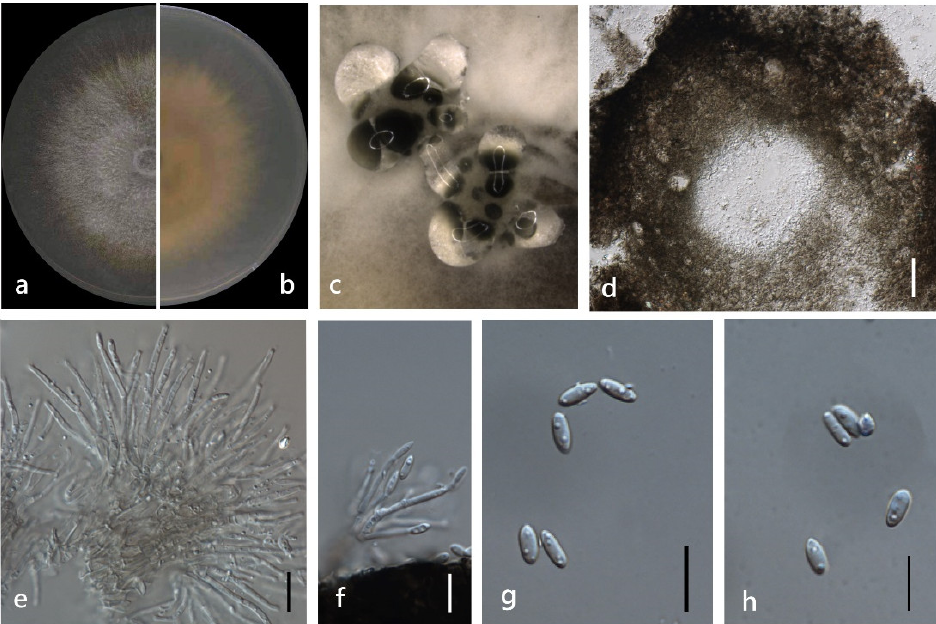
Figure 4. Diaporthe chongqingensis (ZHKUCC 22-0043) ( a ) upper view of colonies on PDA; ( b ) Reverse view of colonies on PDA; ( c ) Pycnidia with conidial droplets on PDA; ( d ) a vertical Section through a